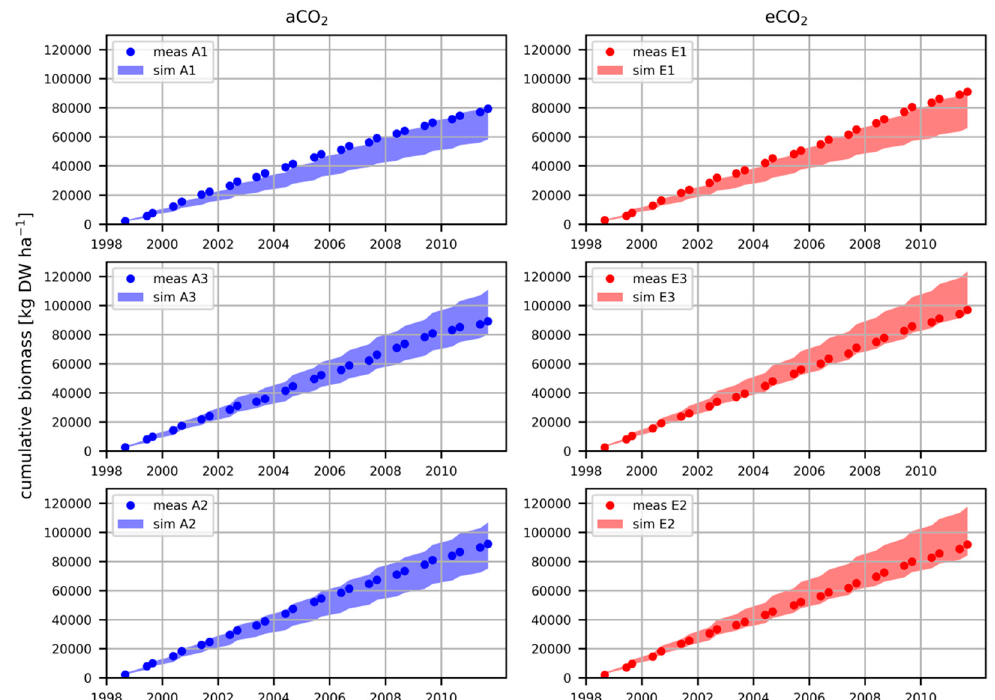
Figure 1. Cumulative measured and simulated values of harvested plant biomass for ambient (aCO 2 ) and elevated CO 2 (eCO 2 ) Free Air Carbon dioxide Enrichment (FACE) rings. Plots are arranged according to increasing soil moisture from driest (top, A1 / E1) to medium (middle, A3 / E3) and wettest (bottom, A2 / E2) rings. Measurements are depicted in dots; confidence intervals of simulations are depicted as colored areas.